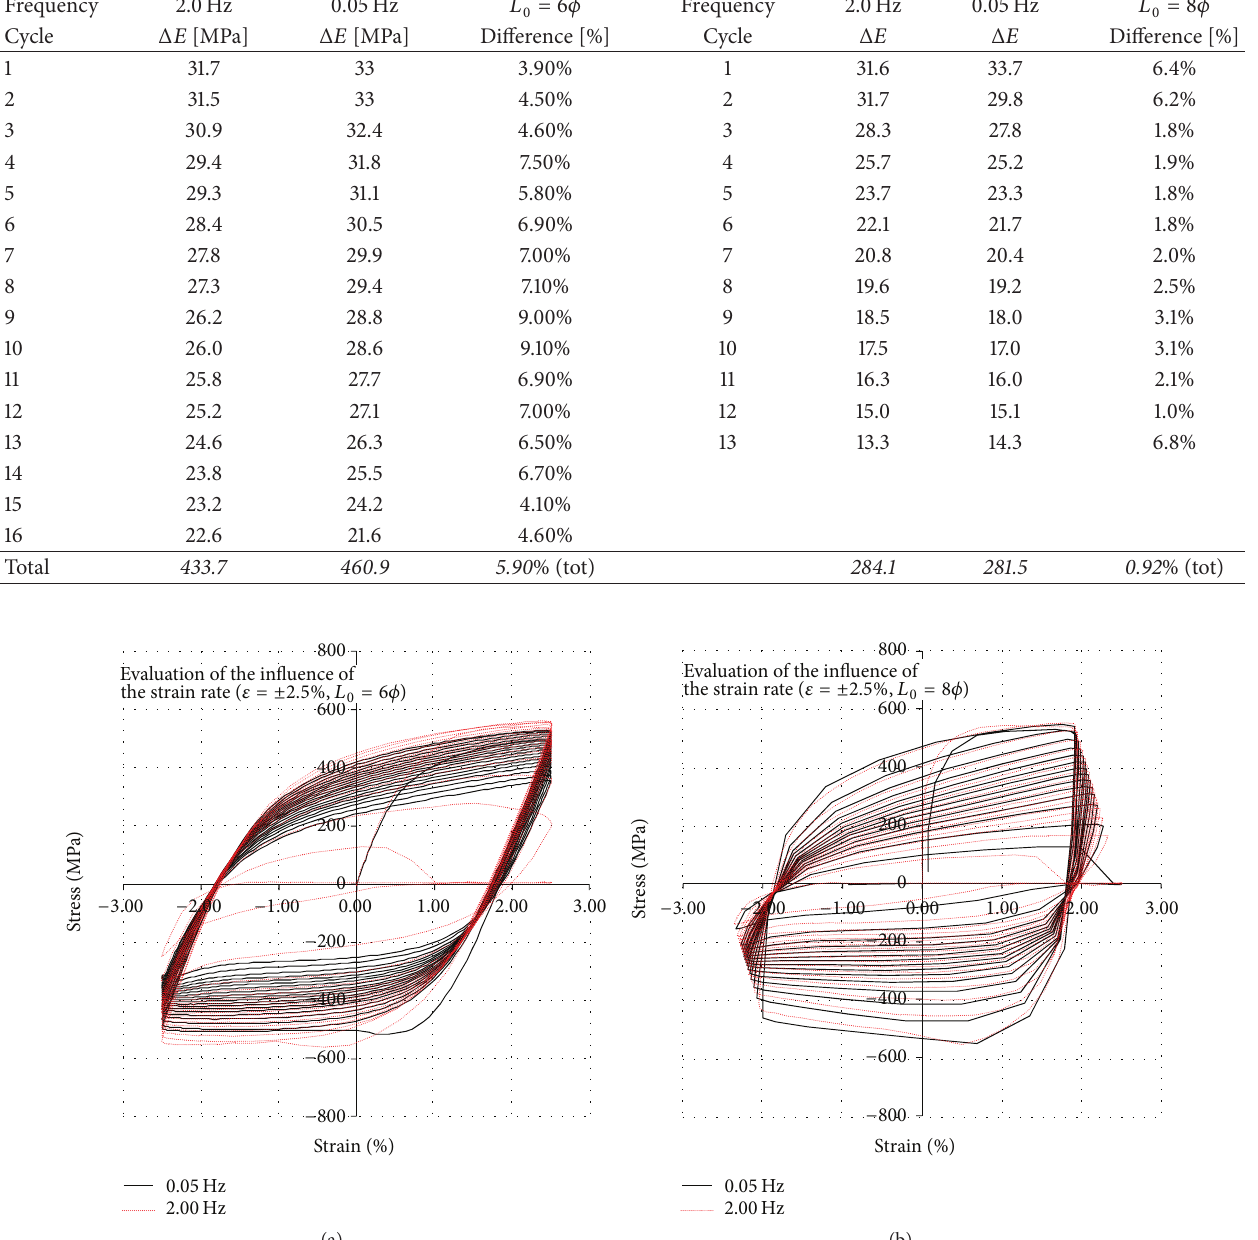
evidenced differences in terms of dissipated energy (total and per cycle) lower than 5–10%; similar values,